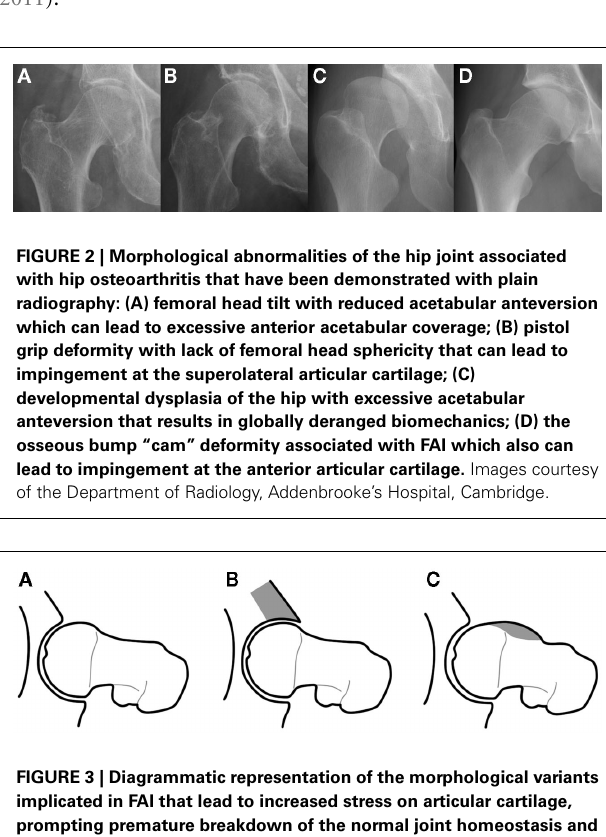
FIGURE 4 | Radiographically moderate osteoarthritis in hypertrophic (A) and atrophic (B) forms. Images courtesy of the Department of Radiology, Addenbrooke’s Hospital,